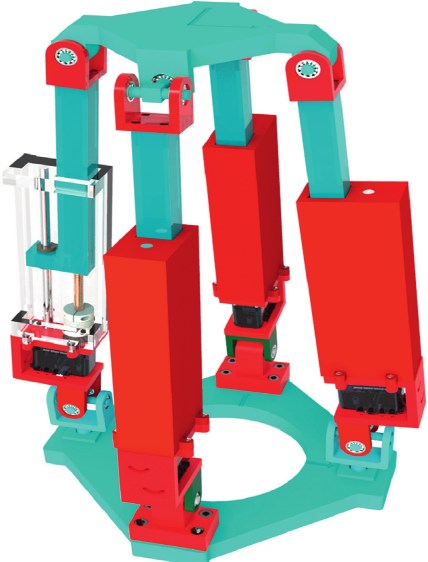
Figure 2: The 3D model of parallel manipulator.